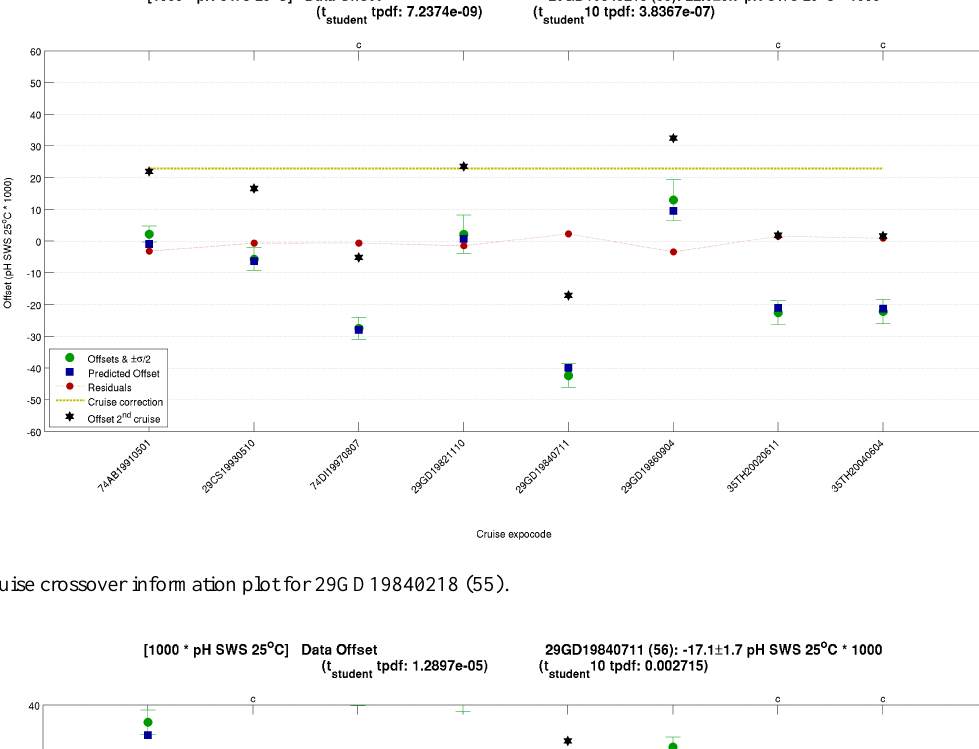
Figure 10. Cruise crossover information plot for 29GD19840218 (55).